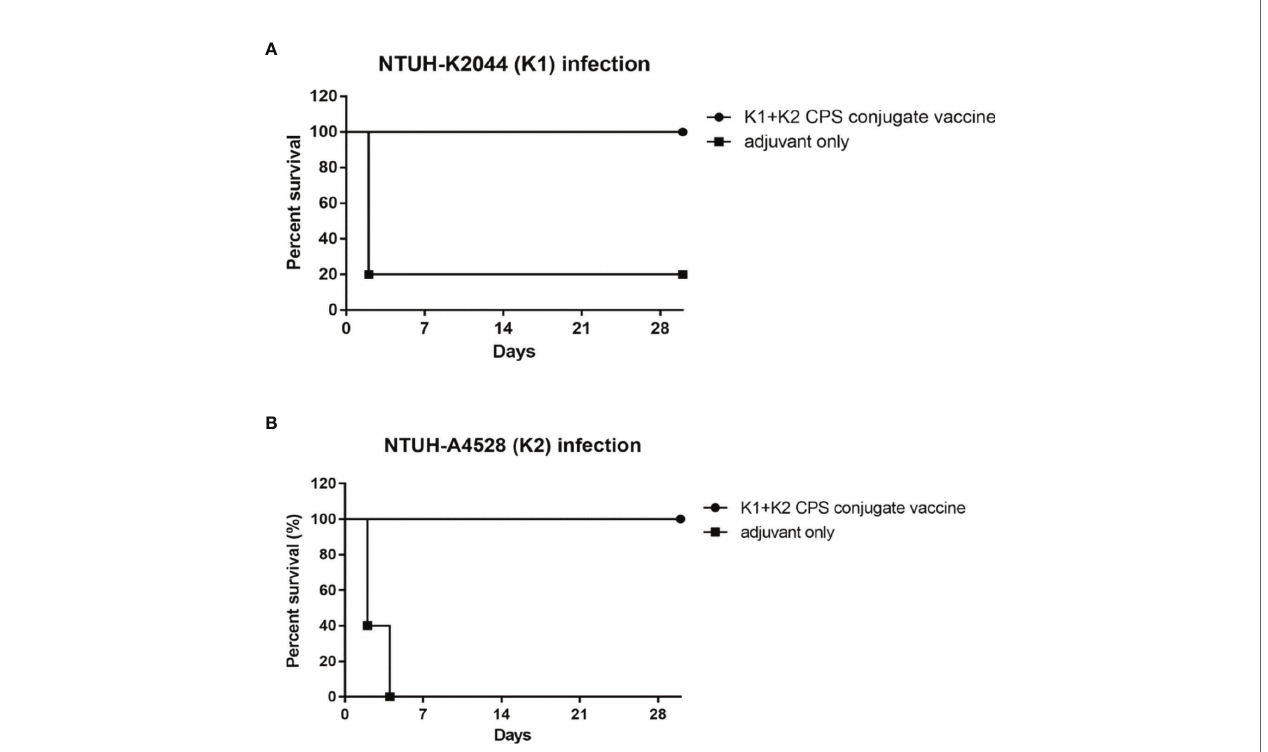
FIGURE 8 | The ef fi cacy of the K1 and K2 CPS-conjugated divalent vaccine in the mouse model. Mice ( fi ve per group) immunized with K1 and K2 CPS-conjugated divalent vaccine were challenged by IP injection of 1×10 4 CFU of K. pneumoniae NTUH-K2044 (A) or NTUH-A4528 (B) per mouse. Vaccination with K1 and K2 CPS-conjugated divalent vaccine signi fi cantly increased the survival rate of mice that were challenged by infection of K. pneumoniae NTUH-K2044 ( P = 0.0143, log- rank test) or NTUH-A4528 ( P = 0.0023, log-rank test),